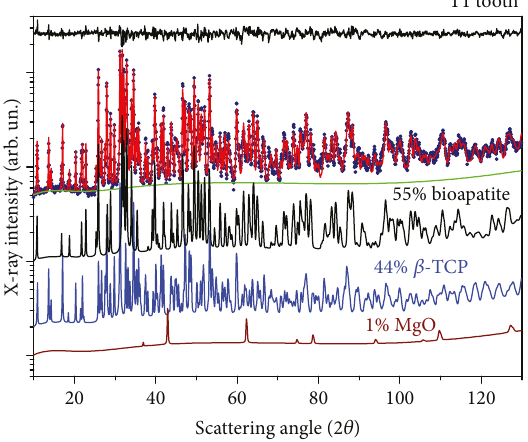
Figure 3: The XRD pattern of T1 tooth heated up to 1050 ° C for 1 hour. The phase analysis suggests that the material is a mixture of bioapatite (55 wt%) and β -TCP (Ca minor contribution of MgO.